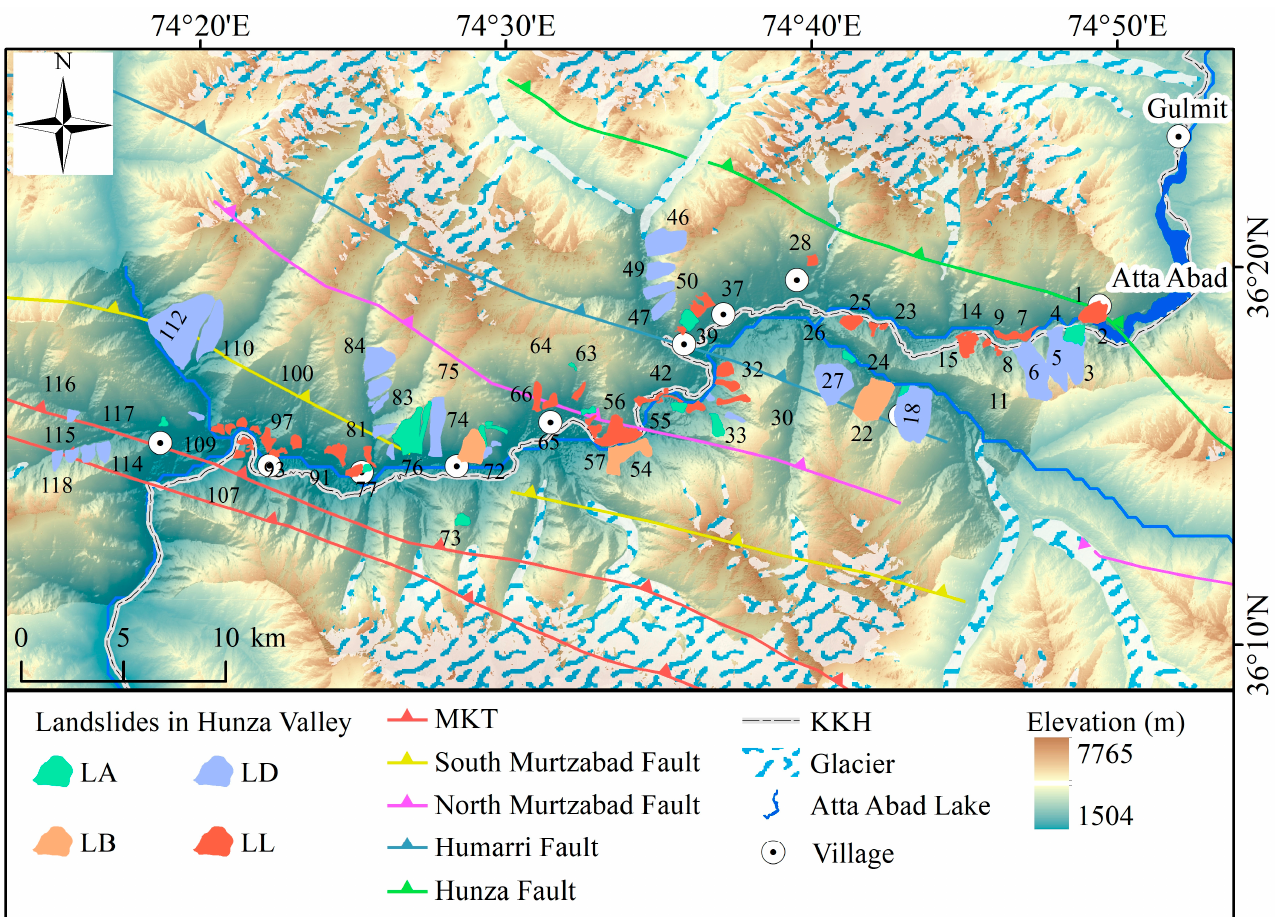
Figure 7. Distribution of landslides detected with multi-track Sentinel-1A data based on SBAS-InSAR, and thrust faults and glaciers in the Hunza Valley, northern Pakistan. LA: the landslide detected by ascending Sentinel-1A, LD: the landslide detected by descending Sentinel-1A, LB: the landslide detected by both ascending and descending Sentinel-1A, LL: the landslide cited from literature.